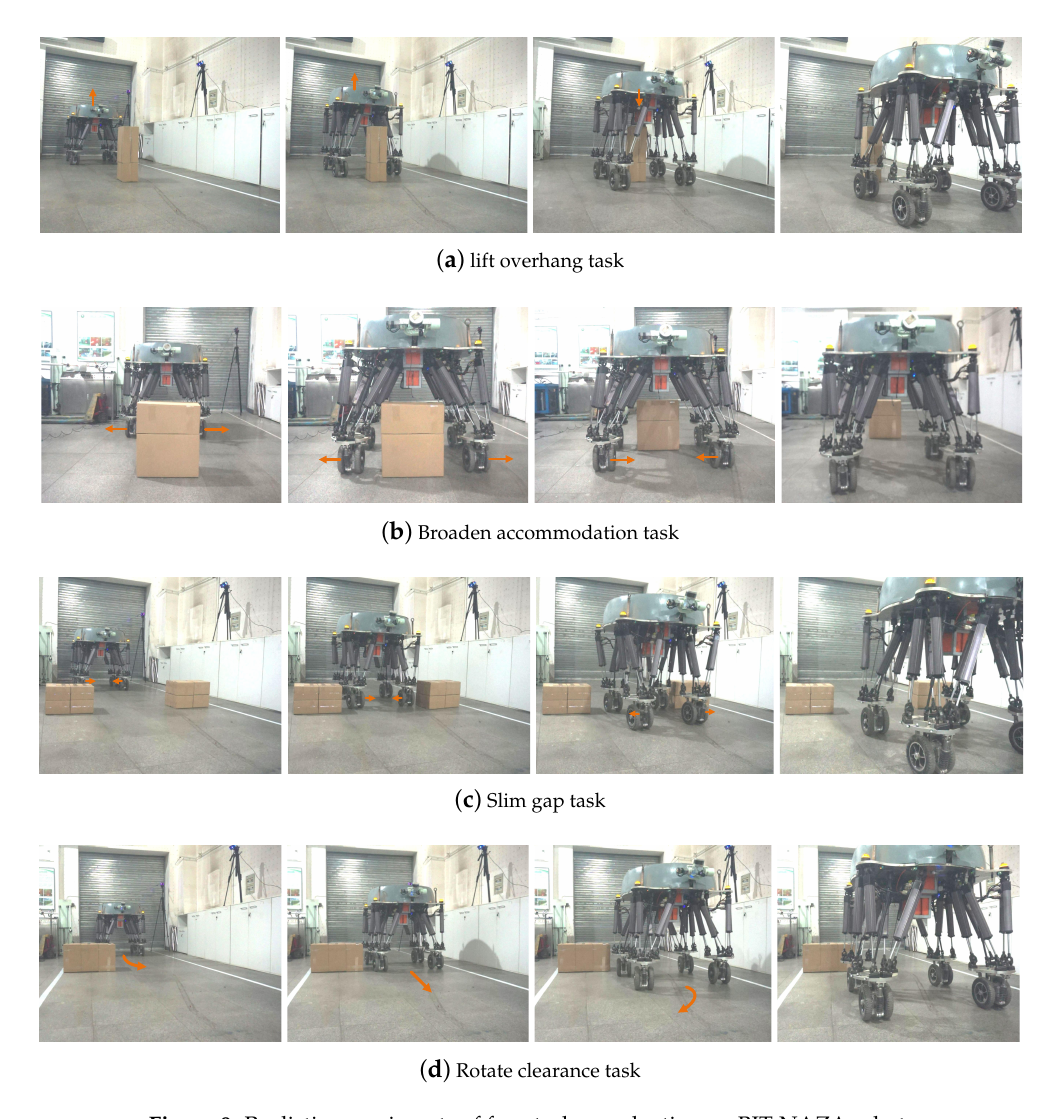
Figure 9. Realistic experiments of four tasks conducting on BIT-NAZA